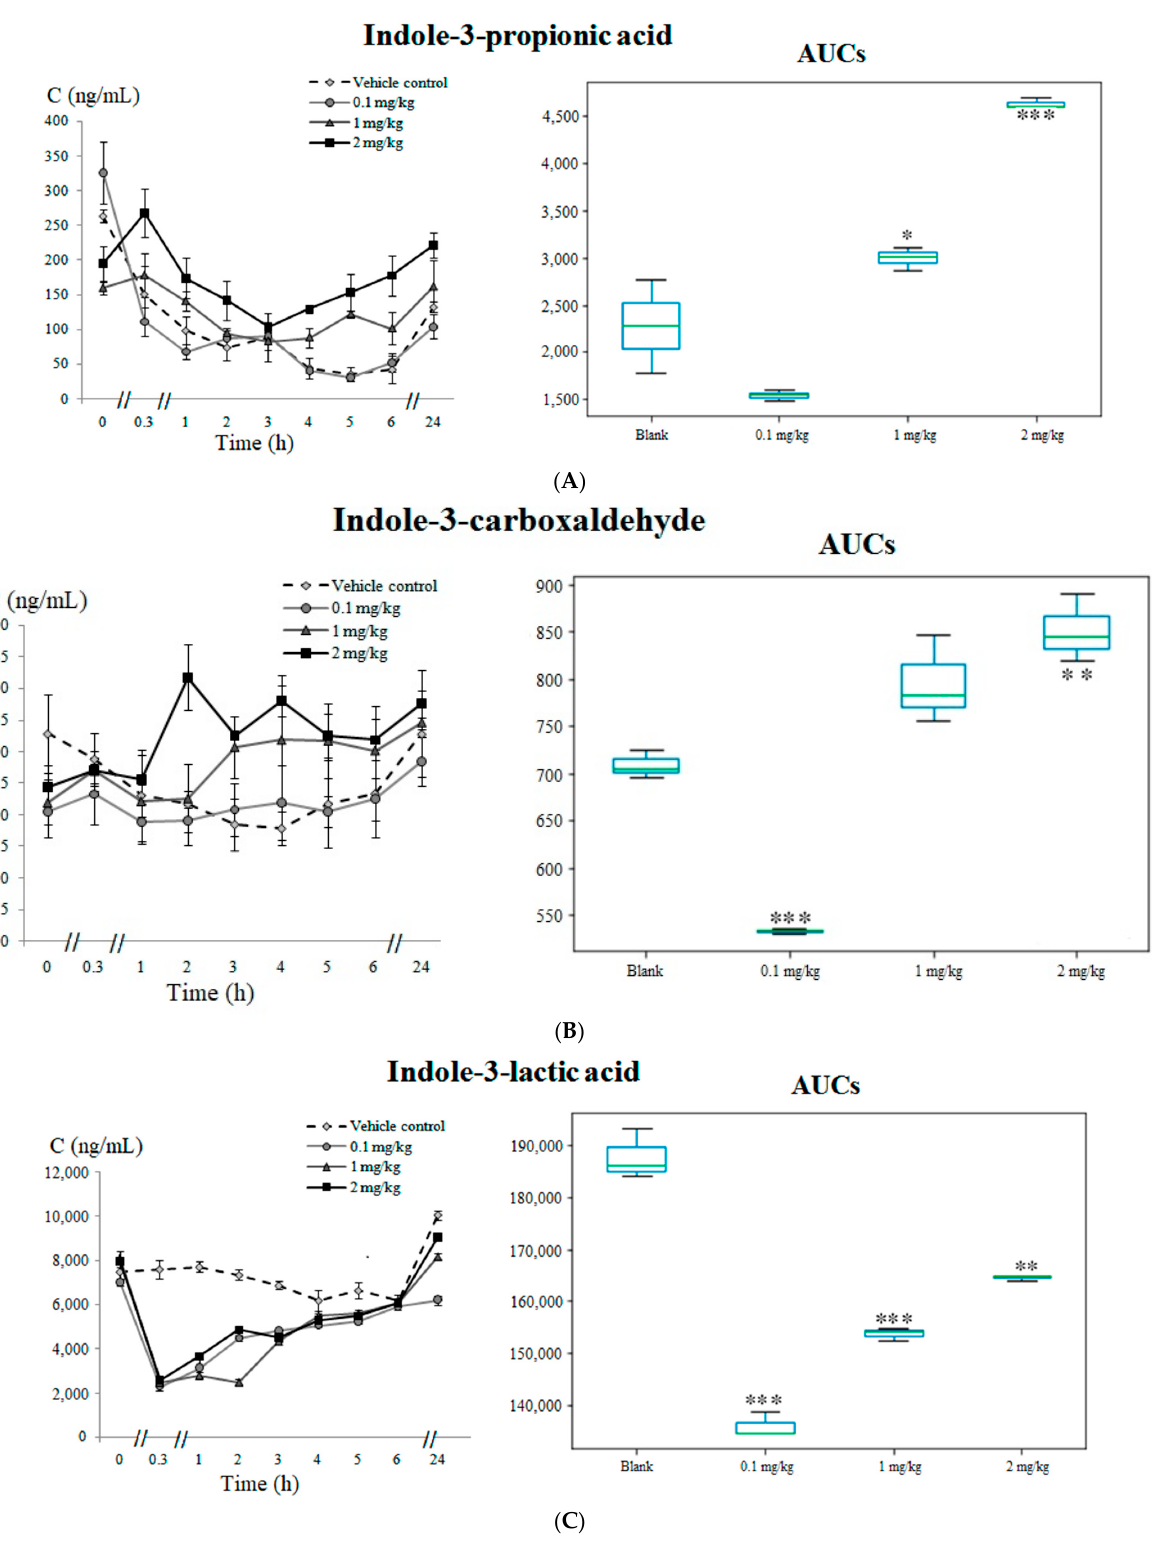
Figure 5. Metabolites related with microbial tryptophan catabolism: ( A ) time-concentration profile and boxplots of the AUC for indole-3-propionic acid, ( B ) time-concentration profile and boxplots of the AUC for indole-3-carboxaldehyde and ( C ) time-concentration profile and boxplots of the AUC for indole-3-lactic acid. Statistically significant differences in the AUCs between the vehicle control and test groups are marked with * p < 0.05, ** p < 0.01 and *** p <